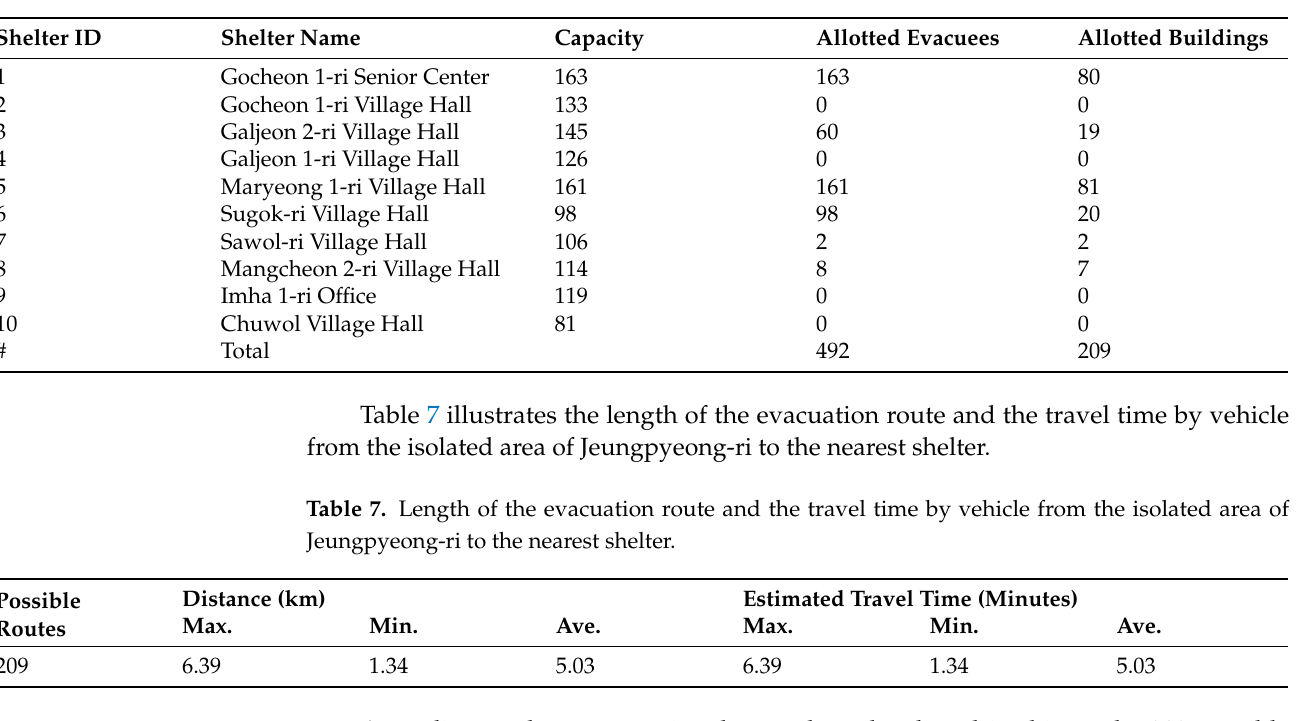
Table 6. Capacity and allocation of shelters by evacuation route in the isolated areas of Jeungpyeong-ri.